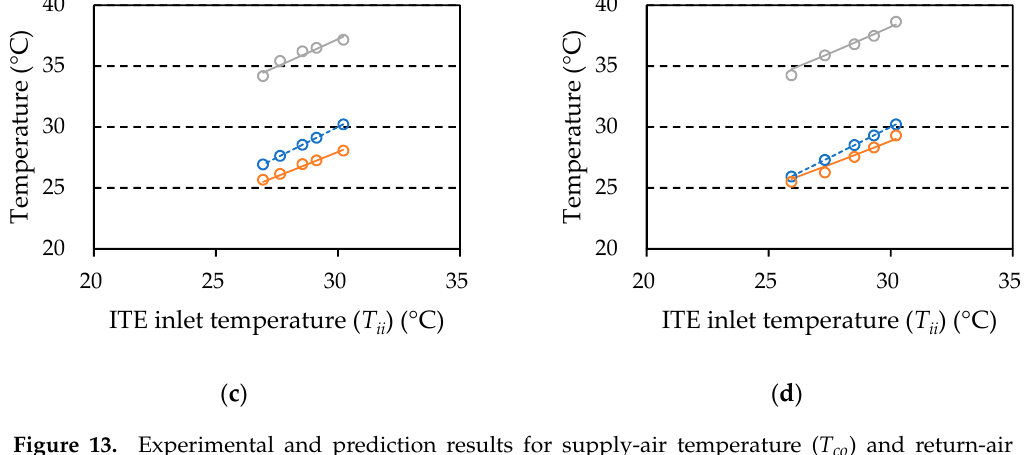
temperature ( T ci ) with respect to ITE inlet temperature ( T ii ): ( a ) C-1, ( b ) C-2, ( c ) D-1, and ( d ) Figure 13. Experimental and prediction results for supply-air temperature ( T co ) and return-air